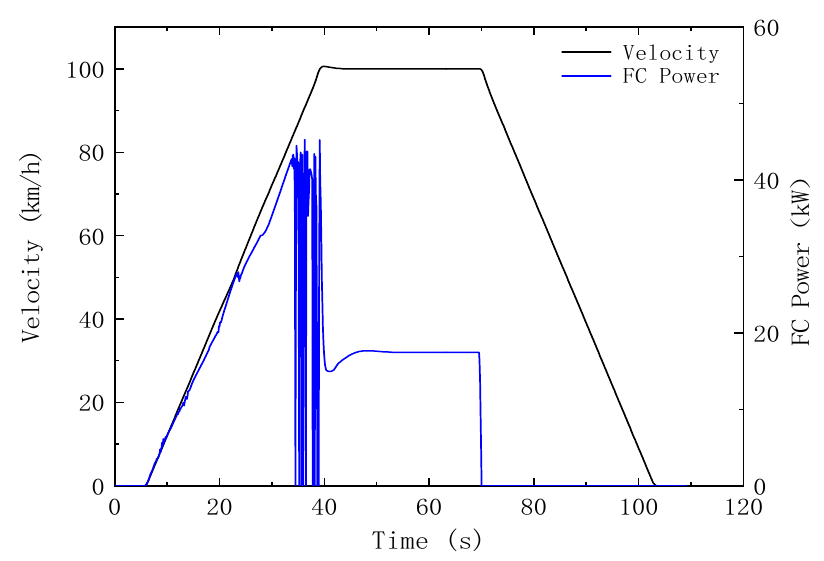
Figure 13. Changes in fuel cell power during 0–100 km / h acceleration of FCV.